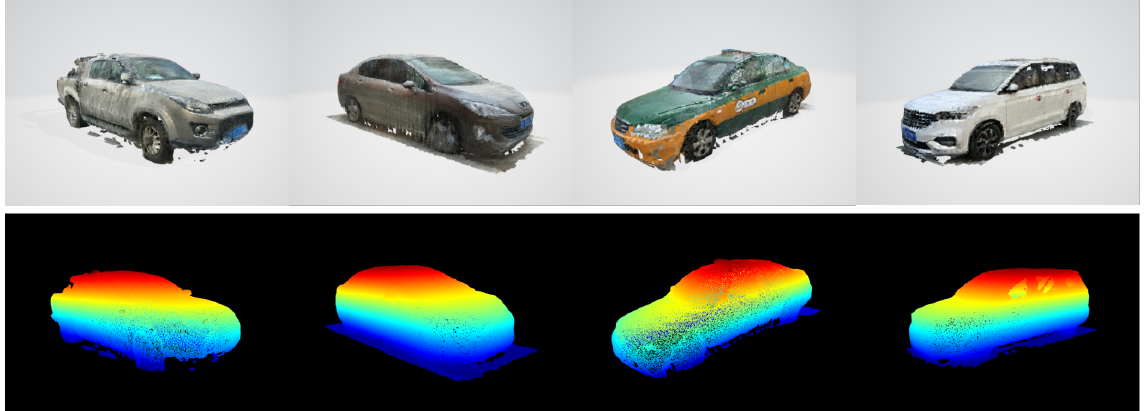
Figure 5. The models and point clouds of real cars scanned by the iPad